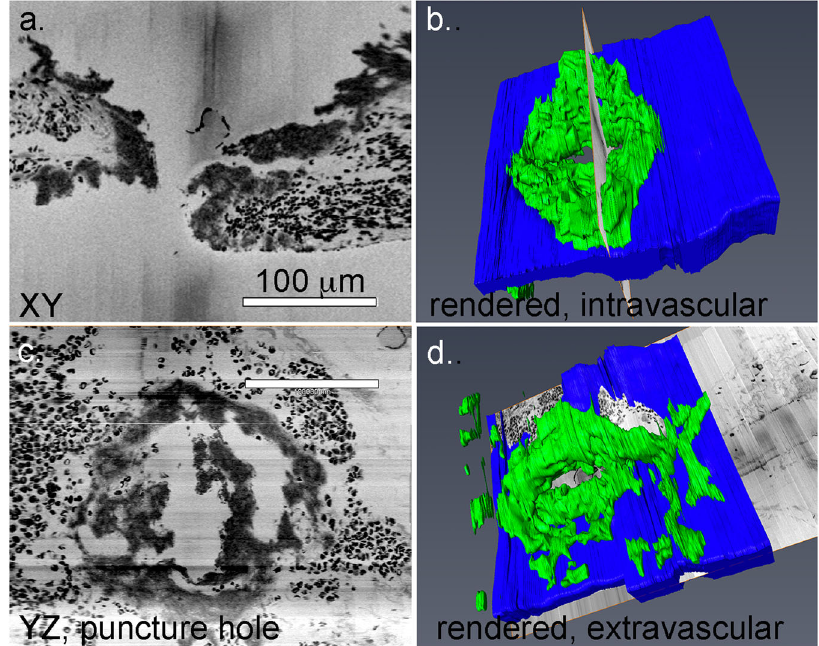
Fig. 5 Morphological evidence for pedestal extension as the starting point for intravascular growth and puncture wound hole sealing. XY cross-section slice through a 1 min post puncture wound hole ( a ) and its placement within the thrombus ( b ). YZ cross-section within the same puncture hole seen as imaged ( c ) and placed within a rendering ( d ). Raw images are 100 nm pixel size, 200 nm spacing in Z -dimension. Viewed from either orientation, the extension of the pedestals through further platelet aggregation appears to be a starting point for further thrombus growth. See also Supplementary Movies 1 and